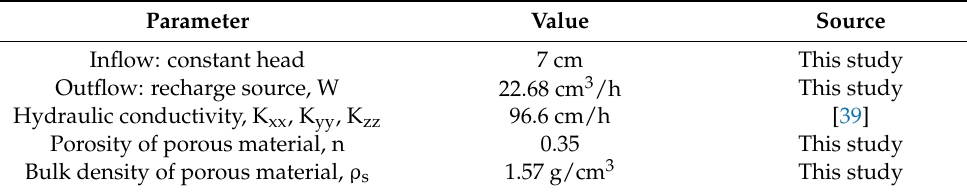
Table 1. Parameters used in the modeling of two-dimensional water flow. Parameter Value Source Inflow: constant head 7 cm This study Outflow: recharge source, W 22.68 cm 3 /h This study Hydraulic conductivity, K xx , K yy , K zz 96.6 cm/h [39] Porosity of porous material, n 0.35 This study Bulk density of porous material, ρ s 1.57 g/cm 3 This